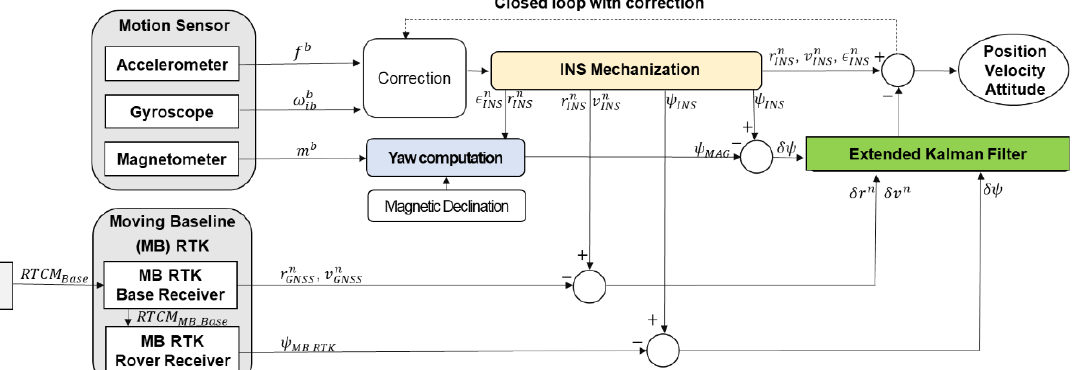
Figure 2. A block diagram of the MB RTK/motion sensor-integrated positioning algorithm. Note: 𝑓 𝑏 is the specific force vector in the body frame, 𝑚 𝑠 2 ⁄ ; 𝜔 𝑖𝑏𝑏 is the angular velocity vector in the body frame, 𝑟𝑎𝑑 𝑠⁄ ; 𝑚 𝑏 is the sign and the magnitude of the e arth’s magnetic field vector in the body frame, mG ; 𝑟 𝐺𝑁𝑆𝑆𝑛 is the position vector consisting of latitude in units of rad , longitude in units of rad , and ellipsoidal height in units of m calculated from the MB RTK base receiver; 𝑣 𝐺𝑁𝑆𝑆𝑛 is the velocity vector consisting of north, east and down velocity calculated from the MB RTK base receiver, 𝑚 𝑠⁄ ; 𝜓 𝑀𝐵 𝑅𝑇𝐾 is the yaw calculated from the MB RTK rover receiver, rad ; 𝑟 𝐼𝑁𝑆𝑛 is the po- sition vector consisting of latitude in units of rad , longitude in units of rad , and ellipsoidal height in units of m calculated from the INS mechanization; 𝑣 𝐼𝑁𝑆𝑛 is the velocity vector consisting of north, east and down velocity calculated from the INS mechanization, 𝑚 𝑠⁄ ; 𝜀 𝐼𝑁𝑆𝑛 is the attitude vector consisting of roll, pitch and yaw calculated from the INS mechanization, rad ; 𝜓 𝑀𝐴𝐺 is the yaw cal- culated using the magnetometers’ measurement , rad ; 𝜓 𝐼𝑁𝑆 is the yaw calculated from the INS mechanization, rad ; 𝛿𝑟 𝑛 is the position error vector consisting of latitude in units of rad , longitude in units of rad , and ellipsoidal height in units of m; 𝛿𝑣 𝑛 is the velocity error vector consisting of north, east and down velocity, 𝑚 𝑠⁄ ; 𝛿𝜓 is the yaw error, rad .